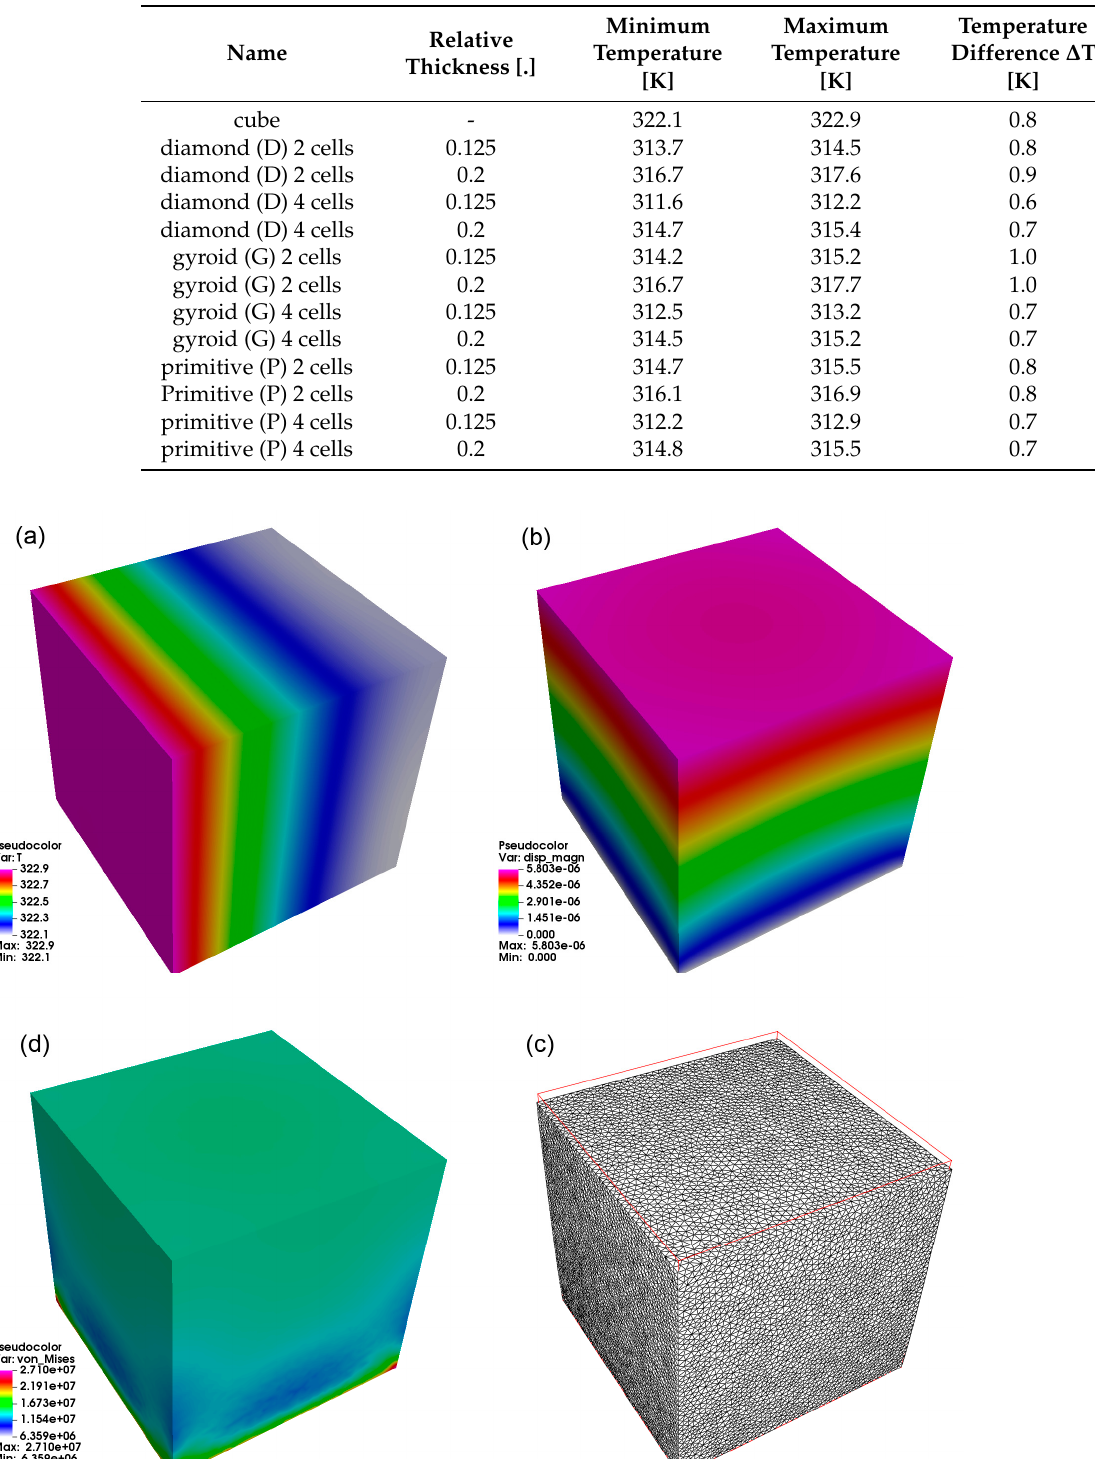
Figure 2. Results for a reference cube. The following result from the upper-left clockwise results: ( a ) heat distribution after 250 s, ( b ) total displacement from stress analysis, ( c ) mesh deformation with scale ×250, and ( d ) von Mises stress distribution in MPa.